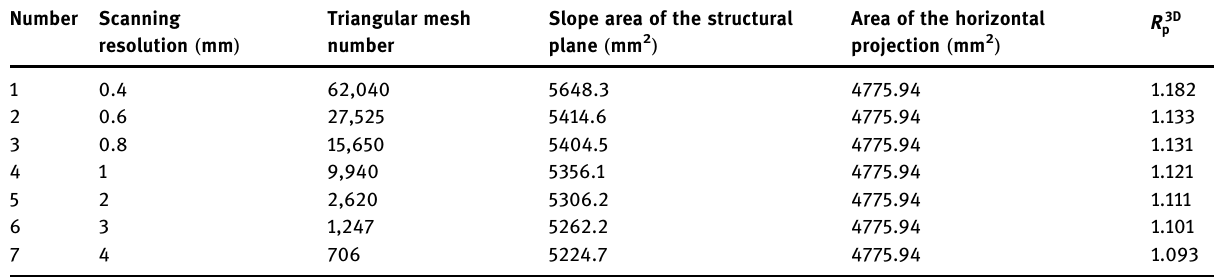
Number Scanning